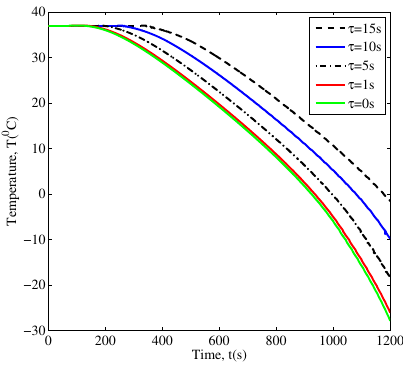
Figure 7. Temperature history at the point x = 0 . 02 m for the time relaxation value τ = 15 s , τ = 10 s , τ = 5 s , τ = 1 s , τ = 0 s